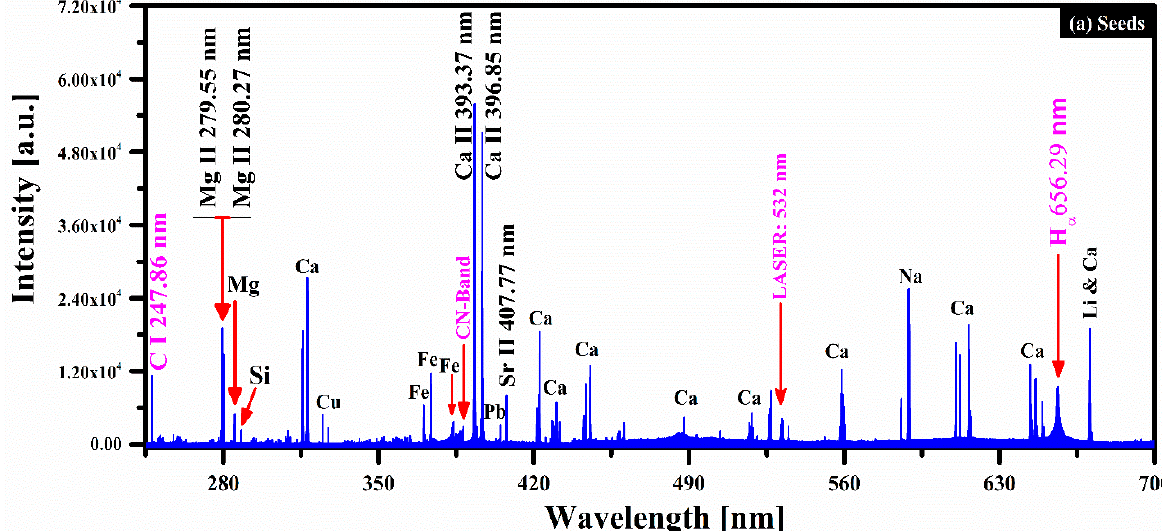
Figure 1. The spectrum of the P. harmala seed sample-( α ) within the wavelength ranges from 245 nm to 700 nm.